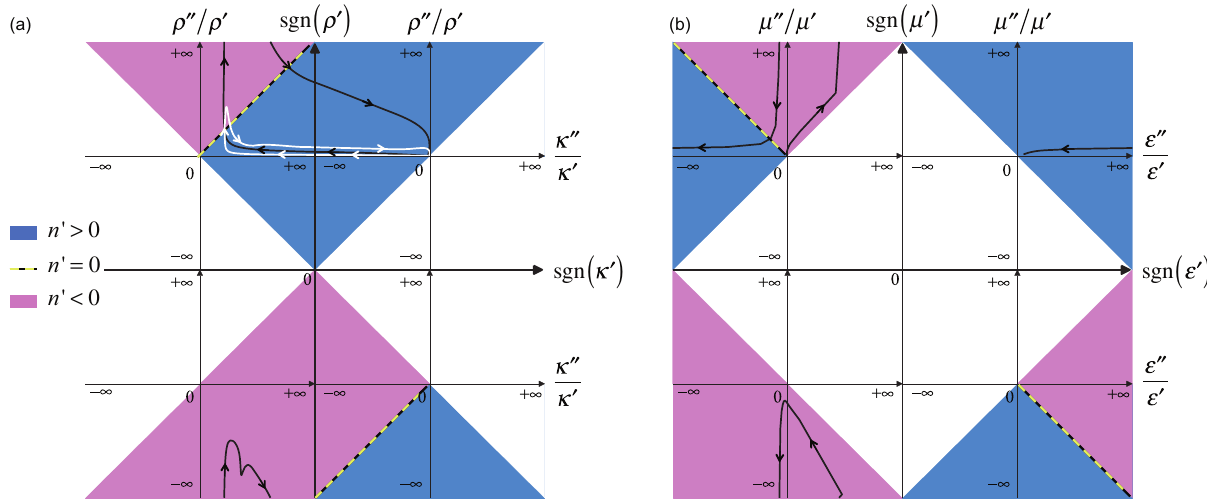
Figure 3. As in Figure 1, the 2D space of the constitutive parameters was explored for (a) acoustic metamaterials [3] with two volume fractions: U = 20% (white curve) and U = 45% (black curve) and for (b) electromagnetic metamaterials [30]. Note that a scale function was used to make the ratio-axis q 00 / q 0 and j 00 / j 0 span the range ] (cid:2)1 , + 1 [. All the values of both ratios have been mapped to the graphical display according to the following function: x 0 = f ( x ) = x /(1 + | x |), where x is an actual value of the considered ratio and x 0 is its graphical position proportional to the length of the semi-axis ( x 0 2 ] (cid:2) 1, +1[). Thus, the origin ( x 0 = 0), the middle ( x 0 = 1/2) and the edge ( x 0 = 1) of the positive semi-axis correspond to ratios ( x = q 00 / q 0 or x = j 00 / j 0 ) equal to 0, 1 and + 1 , respectively. The same property holds for the negative- ratio semi-axis with x and x 0 both